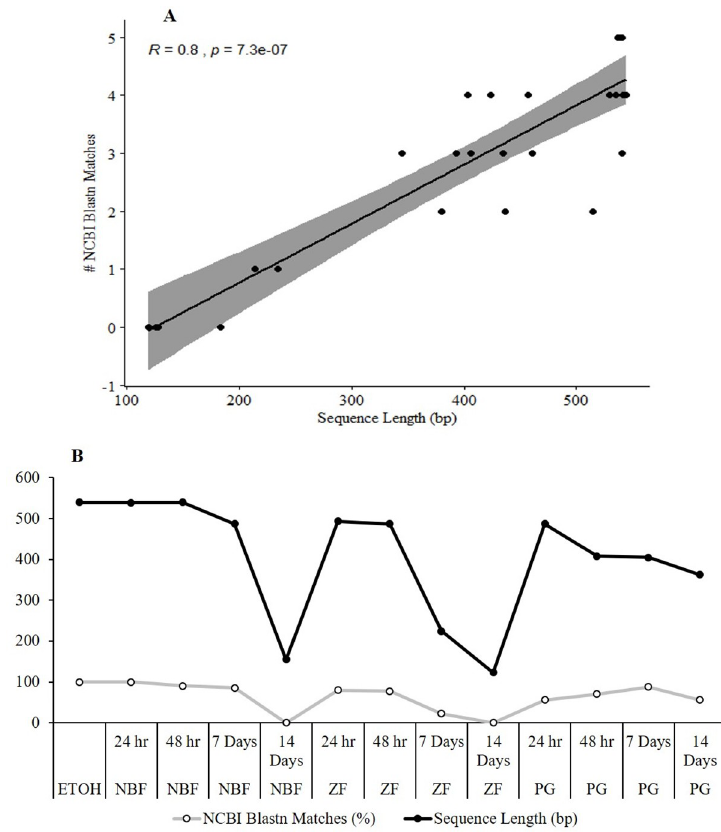
Fig 5. Sanger sequencing and NCBI blastn results. (A) Spearman’s rank correlation analysis of sequence length (bp) and the number of NCBI blastn matches to the Micropterus spp. elongation factor 1 alpha ( EF1 α ) gene. (B) Mean sequence length (bp) of the EF1 α gene obtained with Sanger sequencing and the percentage of sequences with similarity to the Micropterus spp. EF1 α gene.